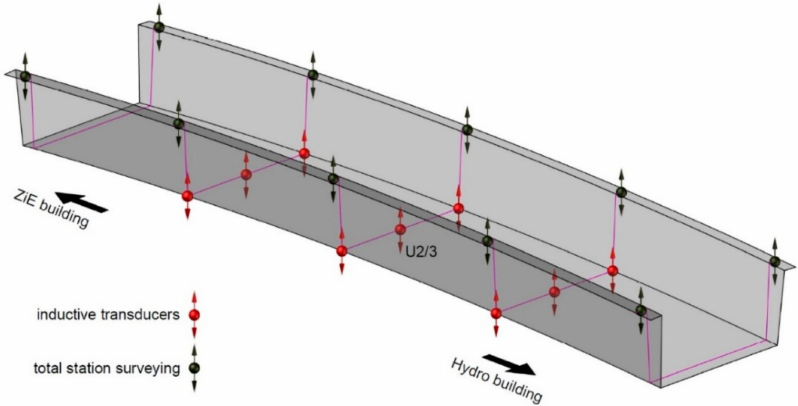
Figure 11. Location of displacement measurement points: inductive transducers and total station